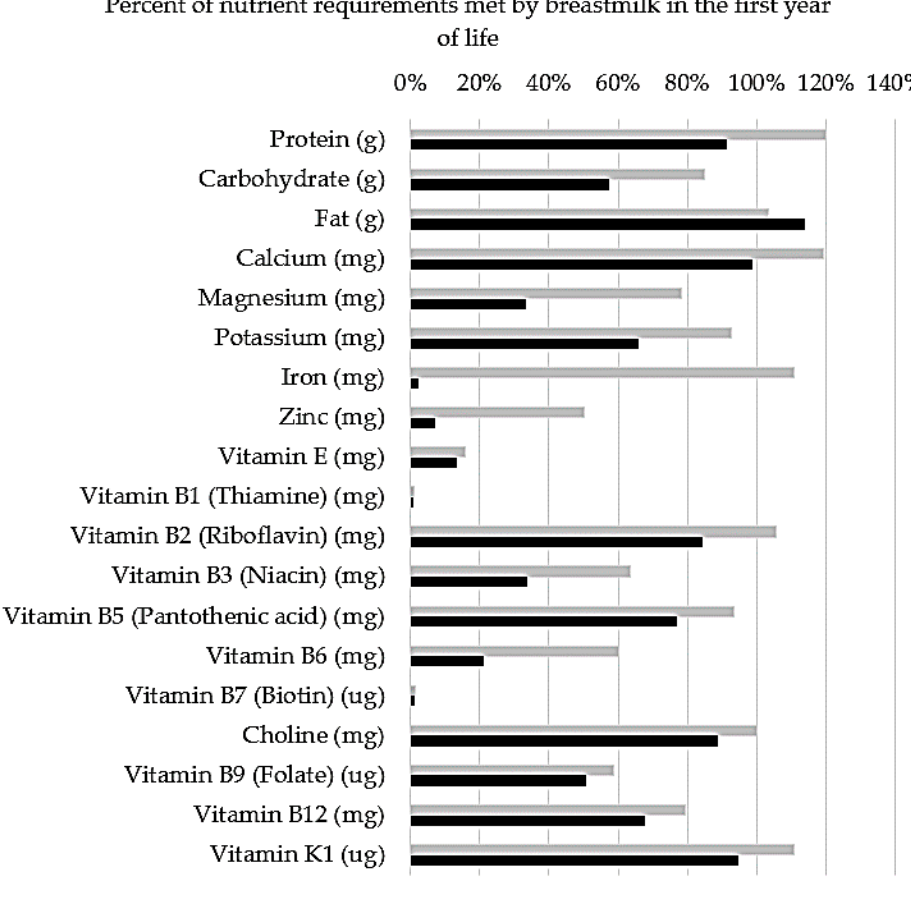
Figure 1. The percent of nutrient requirements based on the recommended daily intakes (RDIs) [49] that are met via average daily breastmilk consumption (750 mL from 0–6 months and 800 mL from 7–12 months) [50].